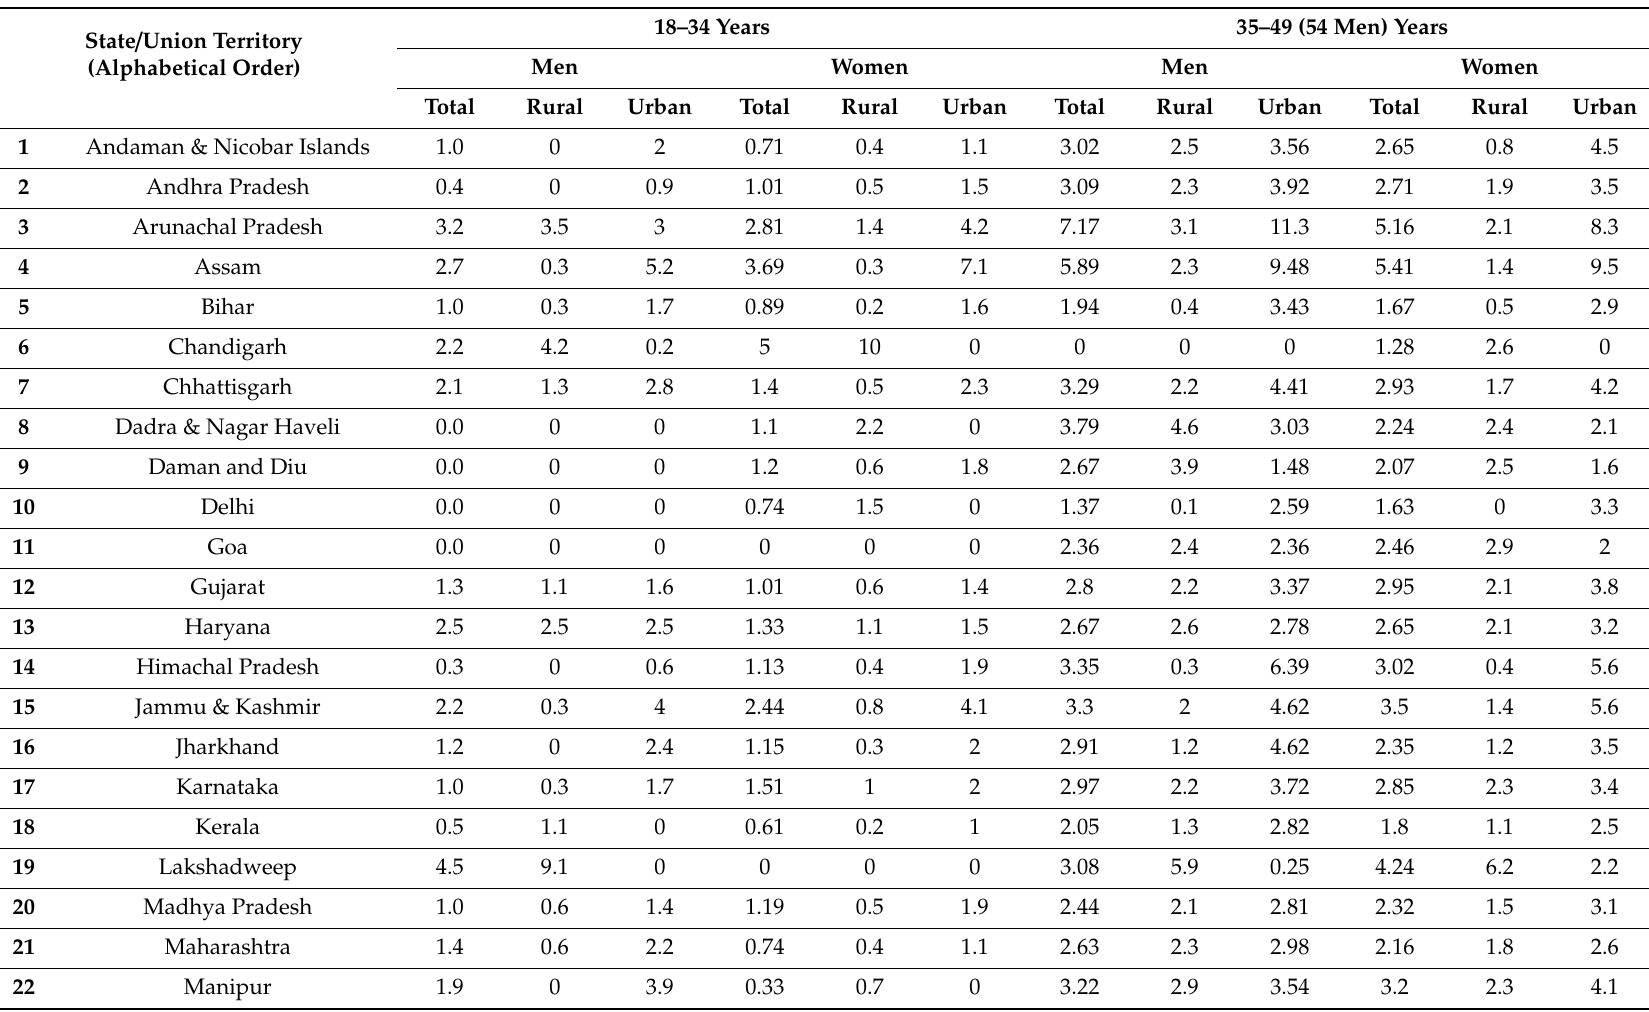
Table 4. The prevalence of hypertension among adults according to age group, sex, and type of residence for each state and union territory. State / Union